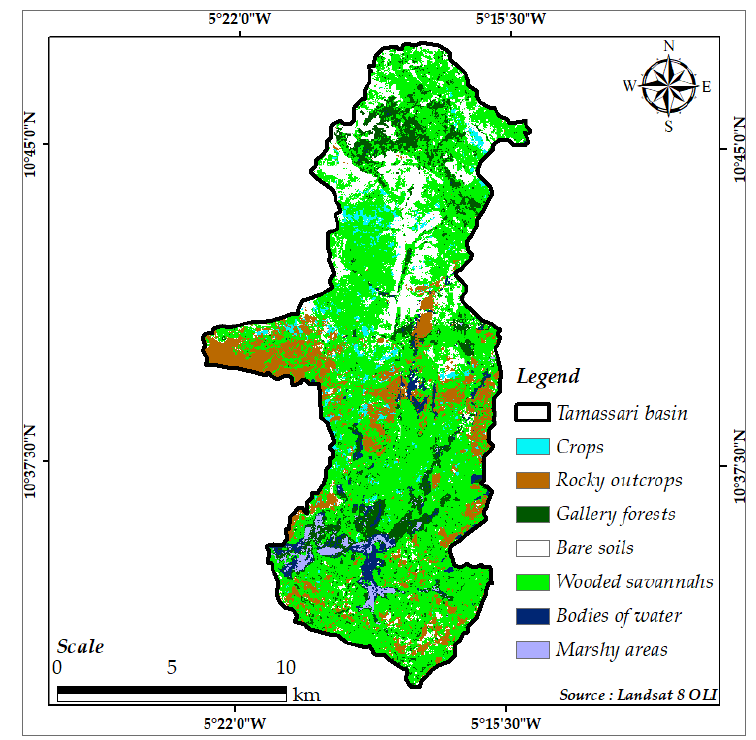
Figure 8. Land use mapping. Figure 8. Land use Table 5. Confusion matrix (Kappa = 0.934).